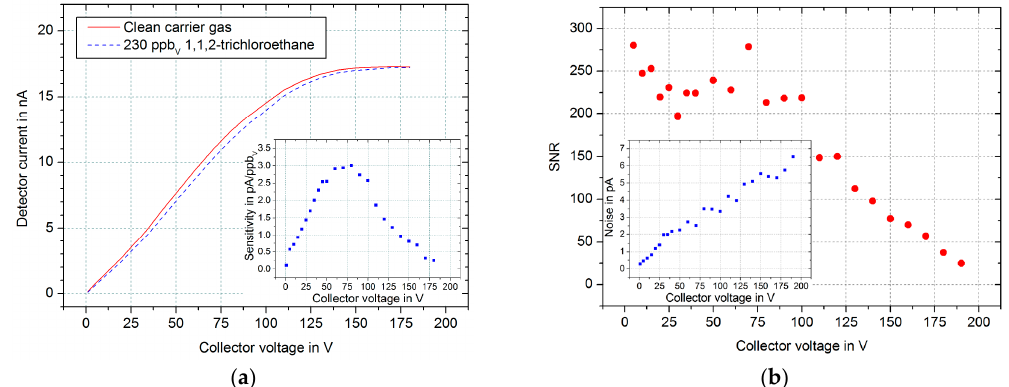
Figure 2. ( a ) Detector signals with pure nitrogen as carrier gas (solid red line) and nitrogen containing 230 ppb v 1,1,2-trichloroethane (blue dashed line) over collector voltage; inset: resulting sensitivity (blue squares) calculated by difference and division by the gas concentration; ( b ) signal-to-noise ratio over collector voltage; inset: standard deviation σ of the measured noise (blue squares).